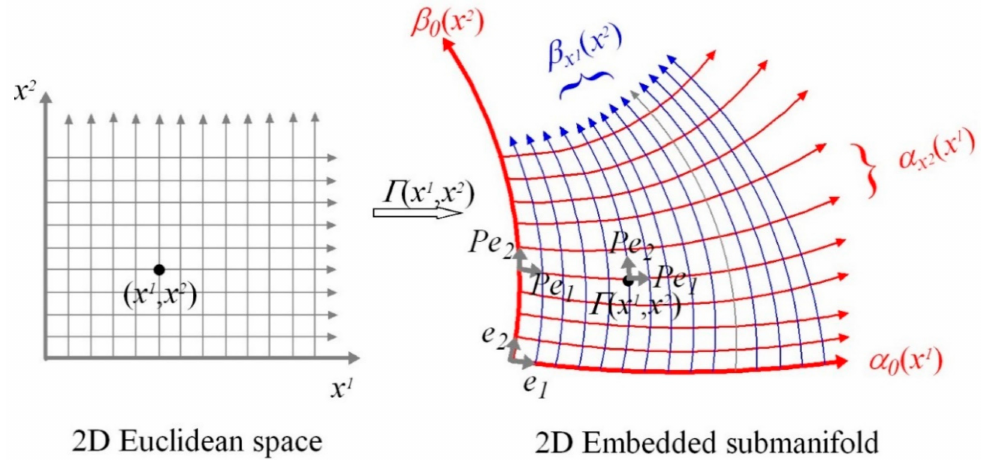
(cid:0) (cid:1) x 1 , x 2 (cid:0) (cid:1) x 1 are geodesics (coloured red) x 2 (cid:0) (cid:1) x 2 are not